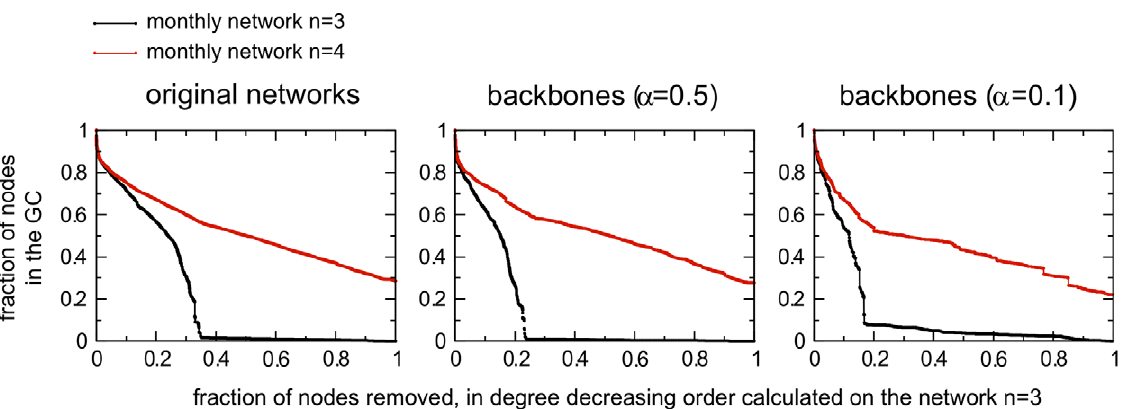
Figure 11. Percolation analysis on consecutive monthly networks. Two consecutive monthly snapshots ( n ~ 3 and n ~ 4 ) have been considered. A list of nodes with decreasing degree is calculated on the snapshot n ~ 3 , and is applied as a removal strategy for both networks. The same procedure has been performed on the corresponding network backbones obtained for two values of the significance parameter a .